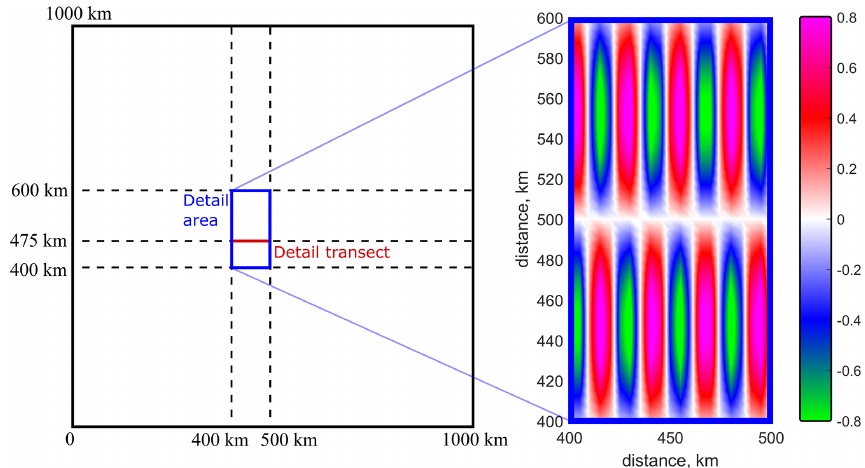
Figure 1. Model domain with a zoomed-in sub-map of idealised spatial distribution of parameter F according to Eq. (9) with a = 4 . 1km, which corresponds to the eddy size of 13km in the x direction, and b = 33 . 3km, which corresponds to the eddy size of 105km in the y direction.